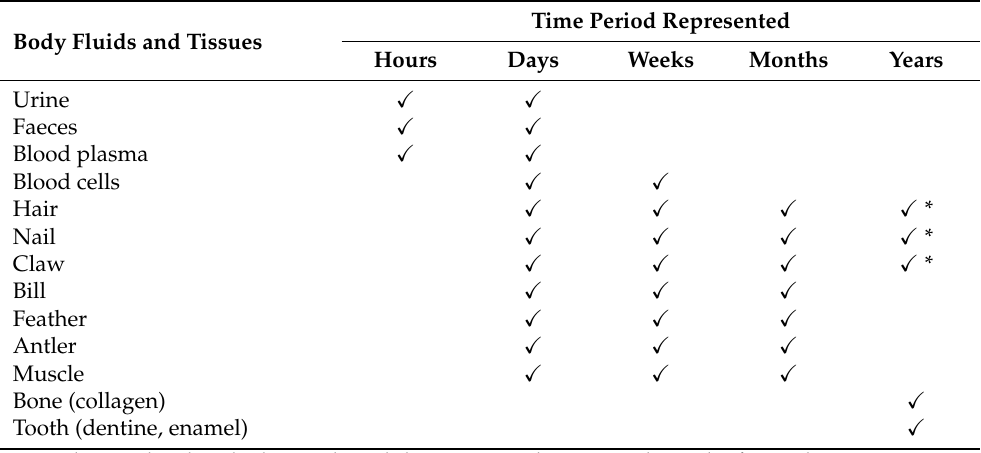
Table 1. Time periods represented by isotopic ratios in different body fluids and soft and hard tissues of